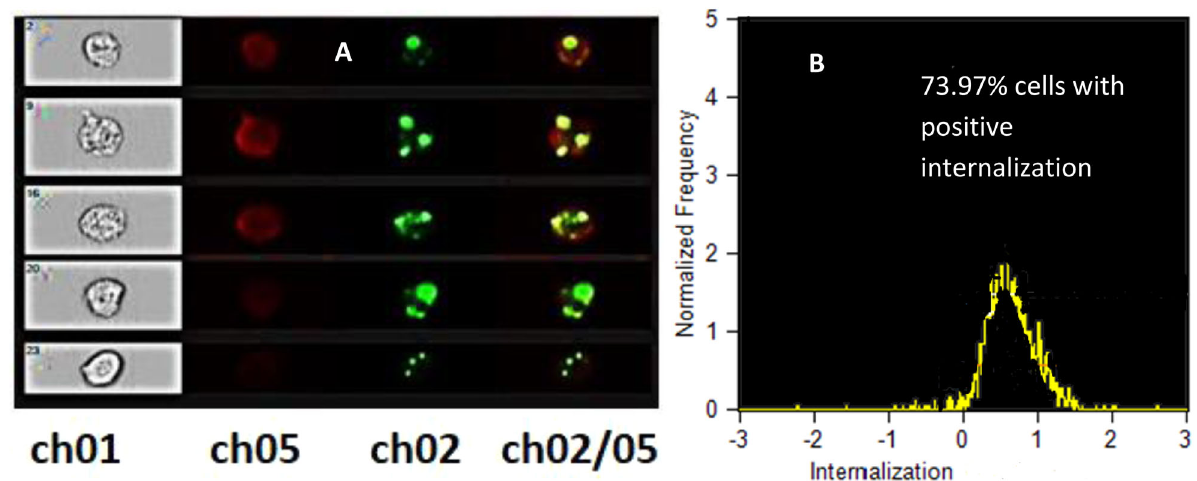
Fig. 6 Uptake of coumarin-6-loaded PLGA NPs by CHO cells using imaging fl ow cytometry. Representative images captured by the Amnis Image StreamX Flow Cytometer of cells treated with D 73.97% cells with positive internalization score coumarin-6-loaded PLGA NPs for 4 h, at 37 °C. A First column (Ch01) shows bright- fi eld (BF) images of the cells, second column (Ch05) shows images of fl uorescence of